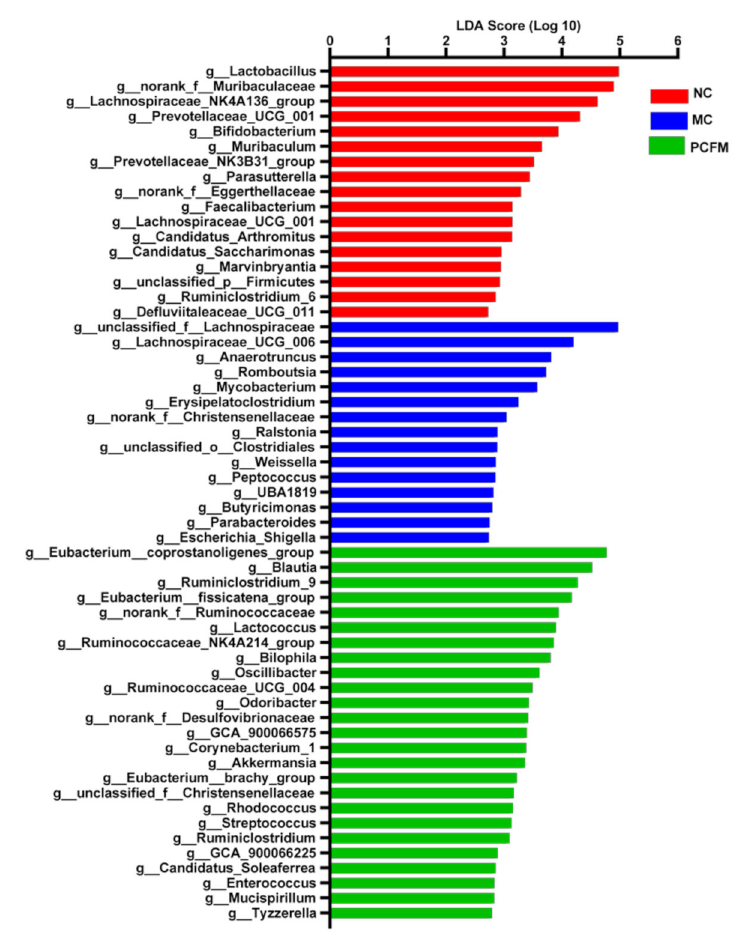
Figure 4. Linear discriminant analysis (LDA) score shows the genus LDA score of > 3 (the length of the bar represents the LDA score) ( n = 7 mice / group). MC: model control group; NC: normal control group; PCFM: prolamin from cooked foxtail millet